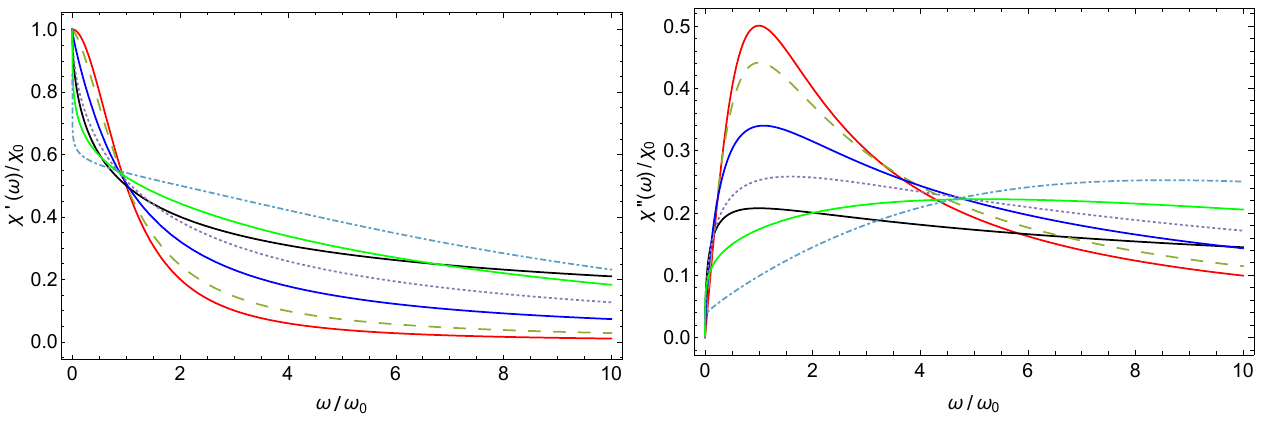
Figure 4. Behaviour of the complex susceptibility as obtained from our solution for the mixed Debye and Cole–Cole relaxation processes. Red lines correspond to pure Debye relaxation, while the black lines correspond to pure Cole–Cole relaxation for the value α = 0.5. The parameters a 1 and a 2 are taken to be a 1 = 0.2 and a 2 = 0.8, respectively. Dashed lines correspond to α = 0.9, blue lines correspond to α = 0.7, dotted lines correspond to α = 0.5, green lines correspond to α = 0.3, and the dot-dashed lines correspond to α = 0.1. Left panel : real part. Right panel : imaginary part (dielectric